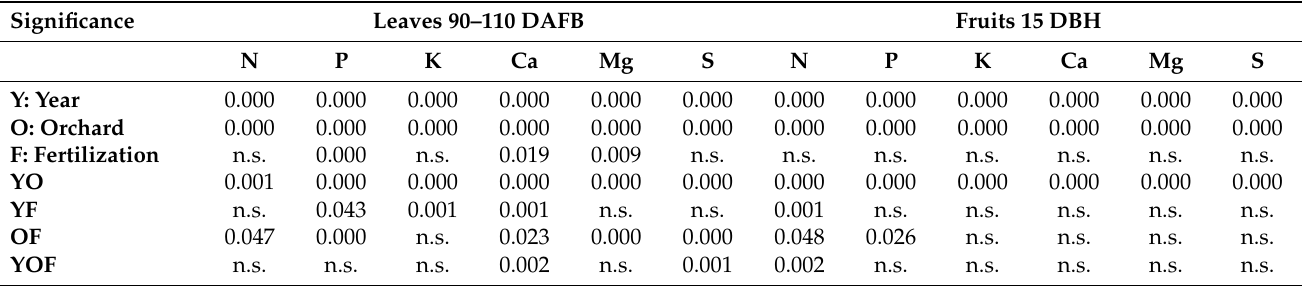
Table 5. p -values of F tests to the principal and interaction effects, based on a 3-way ANOVA with interaction model. The model was fitted to a set of approximately 180 observations for each nutrient, 3 biological replicates by cell.